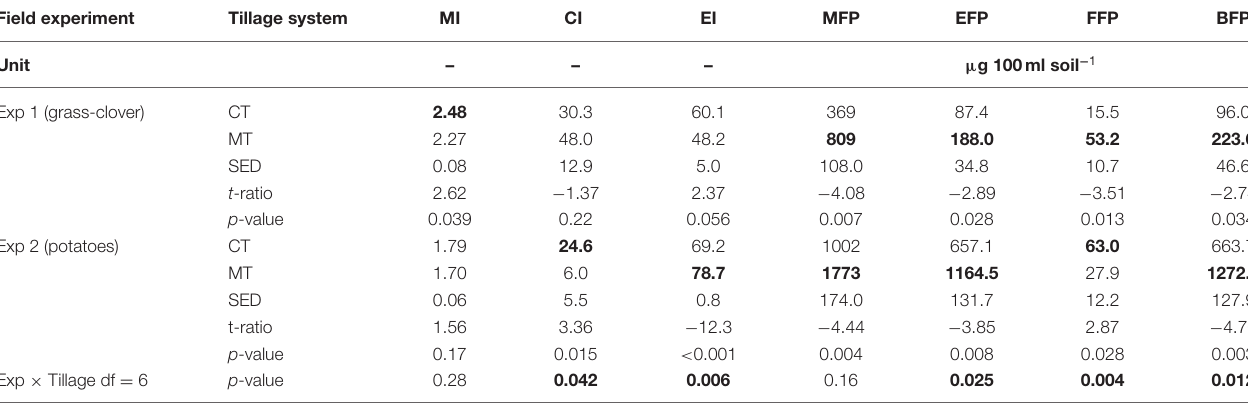
TABLE 2 | Means and standard errors of the difference (SED) for plough tillage plus mineral fertilizer application and minimum tillage including mulch and compost application on the maturity index (MI), channel index (CI), enrichment index (EI), metabolic footprints (MFP), enrichment footprints (EFP), fungivore footprints (FFP), and bacterivore footprints (BFP).